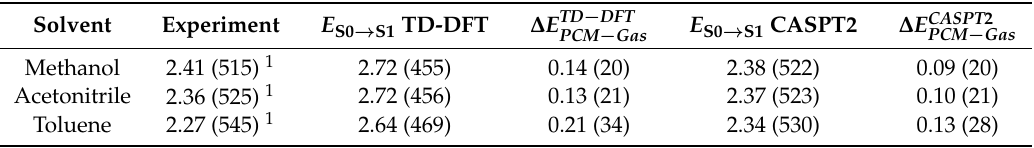
Table 2. Vertical excitation energies ( E S0 → S1 ) for different solvents. All simulated values are calculated by the polarizable continuum model (PCM). All values are given in eV